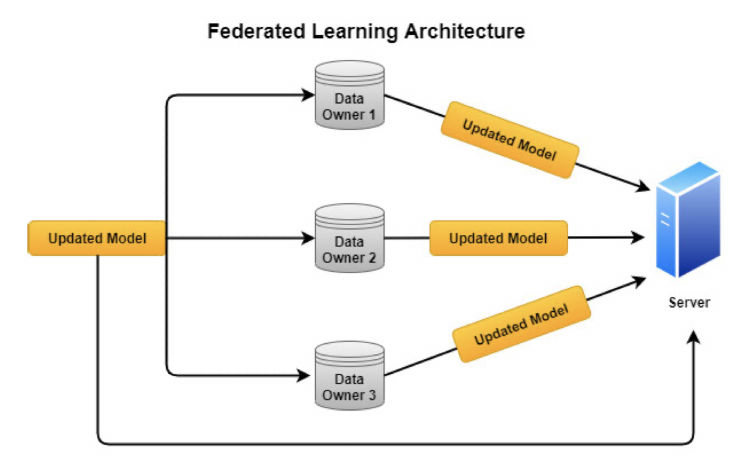
Figure 2. A general overview of how FL works